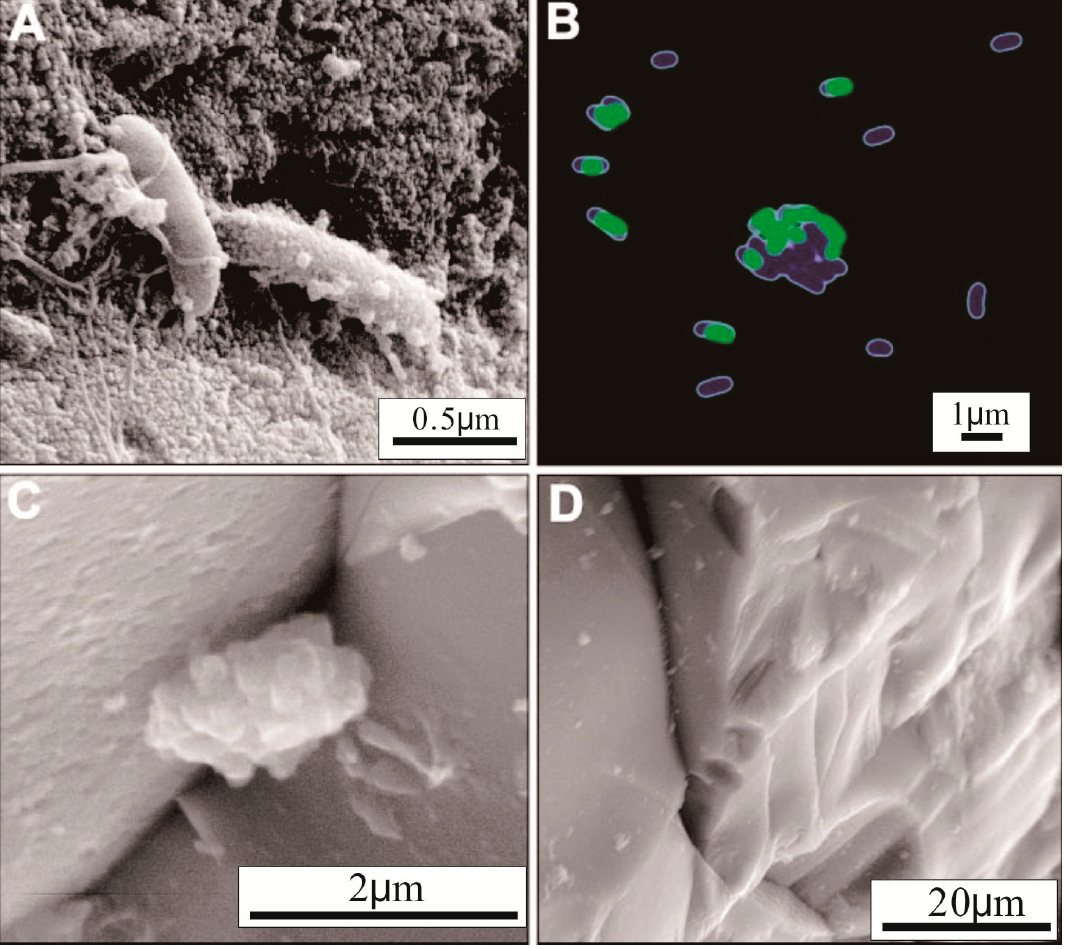
Figure 5. Micrographs of calcium-rich, disordered ferroan dolomite [38]. ( A ) Scanning electron microscopy (SEM) image; ( B ) Scanning laser confocal microscopy image; ( C ) Environmental SEM (ESEM) micrograph; ( D ) ESEM micrograph of the basalt surface in the sterile control.